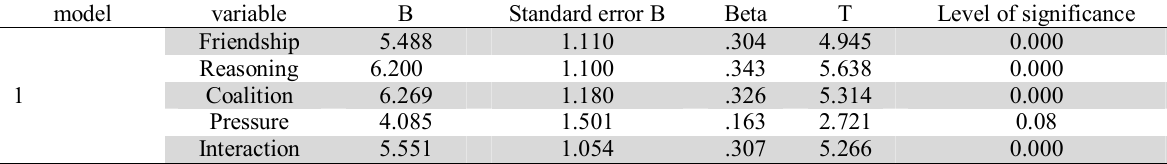
The coefficient of variables used in the regression equation for the male employees model variable